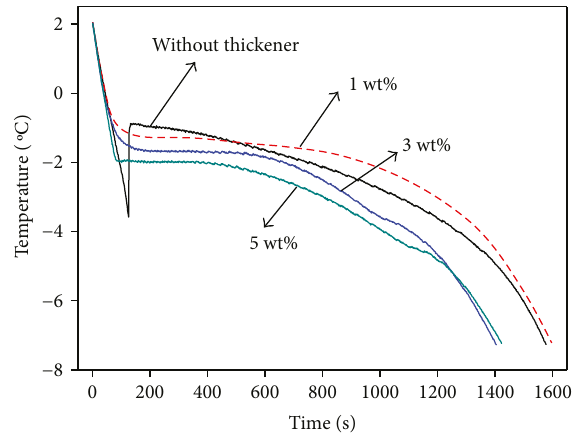
Figure 5: Step cooling curves of adding 1, 3, and 5wt% thickeners in the solution without the nucleating agent. Table 5: Viscosity of water and hydrated salts.